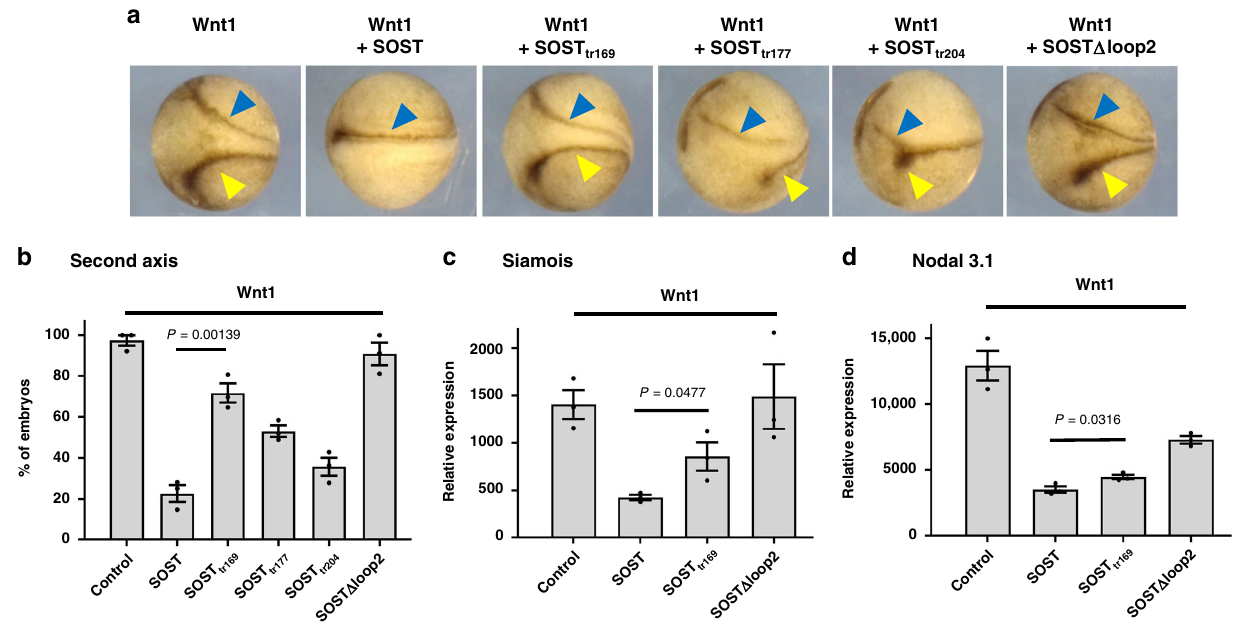
Fig. 5 Assessing the inhibitory effect of SOST on Wnt signaling in Xenopus embryos. a The transverse dark-brown line (blue arrow) indicates the normal position of the axis. The yellow arrow indicates the position of the second ectopic axis. Wnt1 induced formation of the second ectopic axis, and successfully inhibiting Wnt resulted in the formation of a single axis. Embryos at the four-cell stage were co-injected in a ventro-vegetal blastomere with 30 pg Wnt1 mRNA ( n = 104), 25 pg WT SOST mRNA ( n = 106), 25 pg SOST tr169 mRNA ( n = 98), 25 pg SOST tr177 mRNA ( n = 119), 25 pg SOST tr204 mRNA ( n = 104), and 25 pg SOST Δ loop2 mRNA ( n = 96) ( n number of embryos). b The percentage of embryos with a second axis. The error bars represent the standard error of the mean (SEM) from three independent experiments ( n = 3) and p value by two-tailed t -test is indicated. The number of injected embryos is described in a . c , d Real-time qPCR analyses of the expression of genes directly targeted by Wnt1, namely siamois ( c ) and nodal 3.1 ( d ) from animal cap explants isolated at stage 8 and grown to stage 11. The error bars represent SEMs from three independent experiments ( n = 3) and p values by two-tailed t -test are